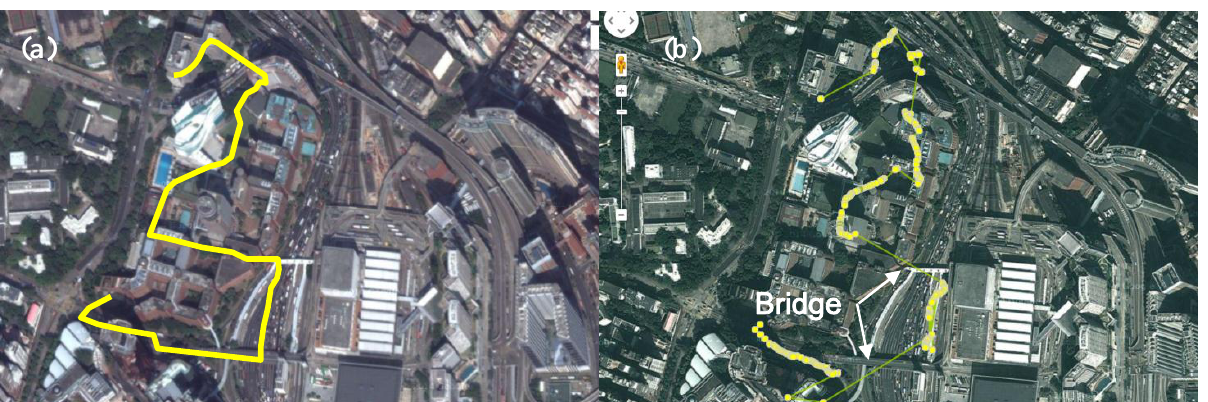
Figure 16. ( a ) Planned route for field test (yellow line); ( b ) data collection of field test (yellow